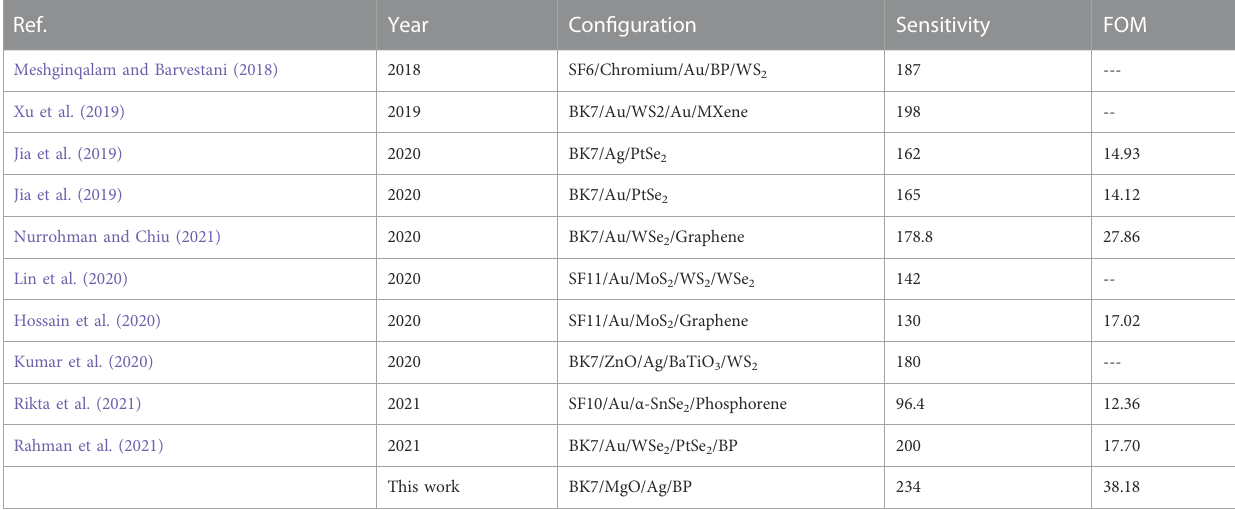
TABLE 3 Comparison of the sensitivity and FOM with some of recently reported SPR sensors.